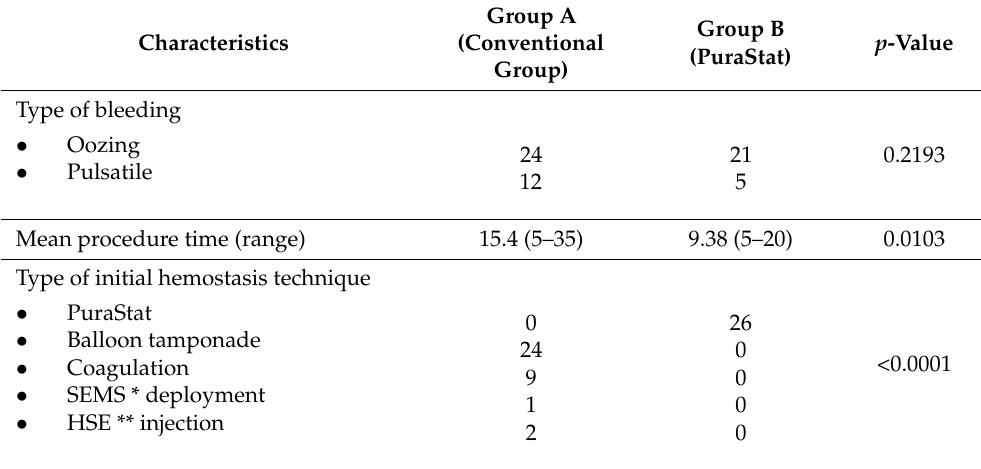
Table 2. Details of the